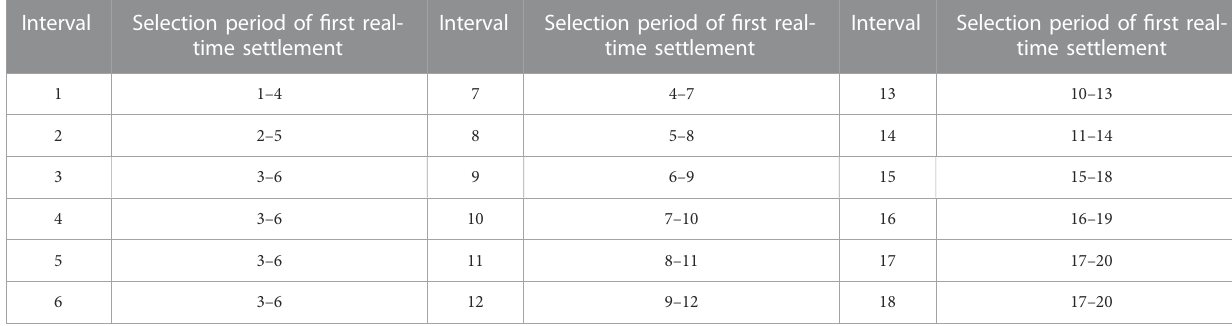
TABLE 2 The selection result of fi rst-settlement in the fi rst 18 intervals.